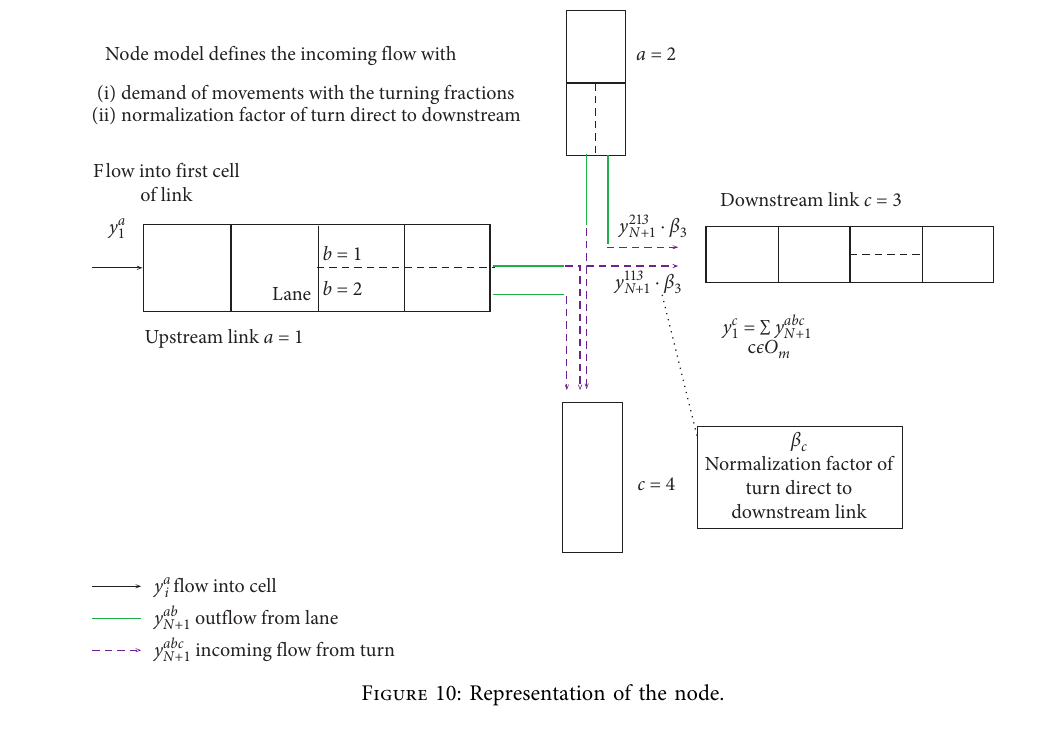
Figure 10: Representation of the node.